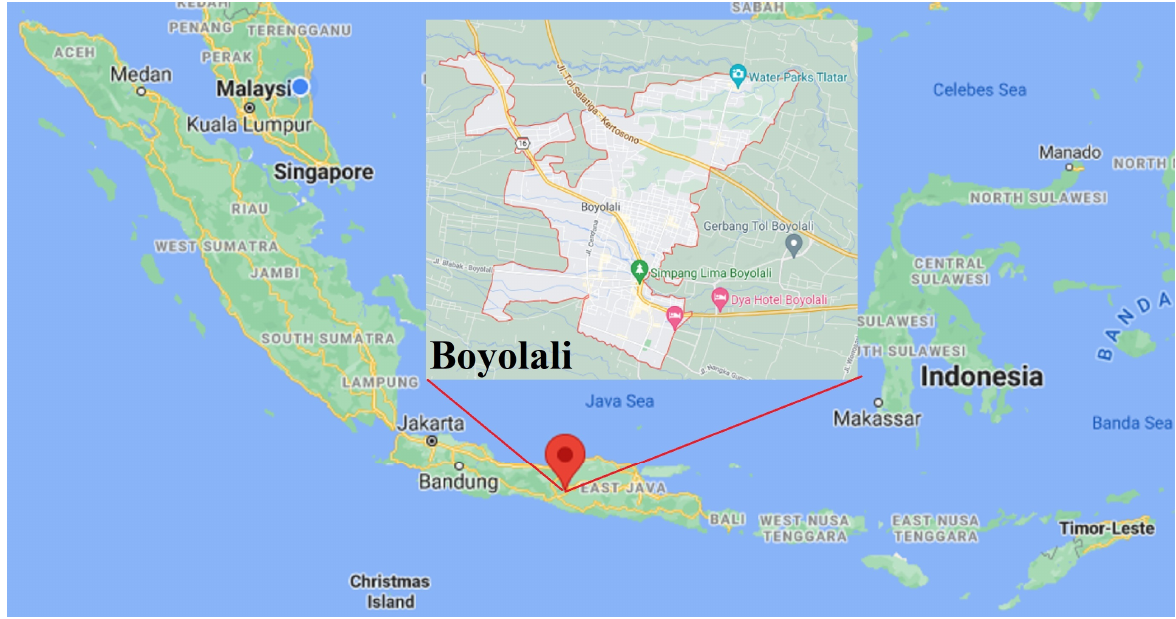
Figure 1. Data collection site of the cross-sectional study. Boyolali, Boyolali Regency, Central Java,